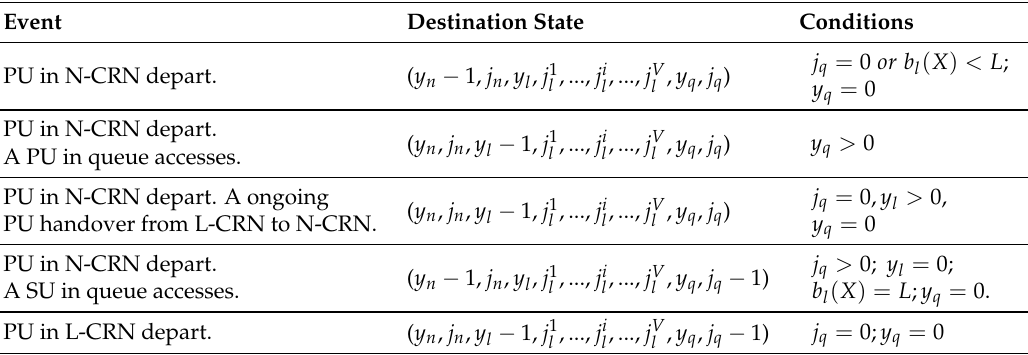
Table 2. Transitions of DFSL when a PU